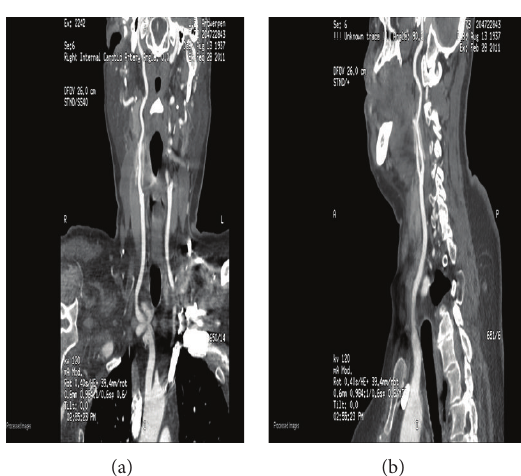
Figure 4: (a) AP view; (b) lateral view. The Teflon can be seen surrounding the